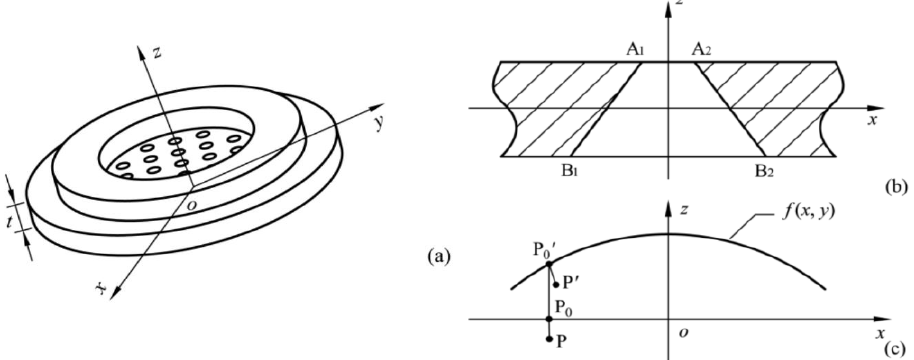
Figure 3. Schematic coordinate of the dispenser. ( a ) Coordinate system of the dispenser; ( b ) Profile of a tapered aperture; ( c ) Deformation process of a point in the dispenser.